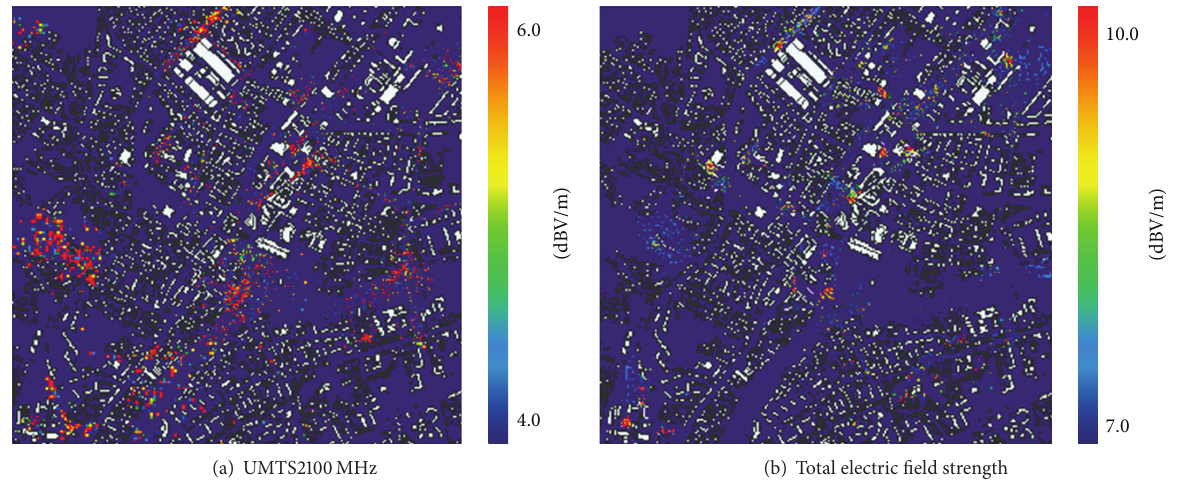
Figure 13: Maps of maximum values of total electric field strength for UMTS2100 and total electric field strength.